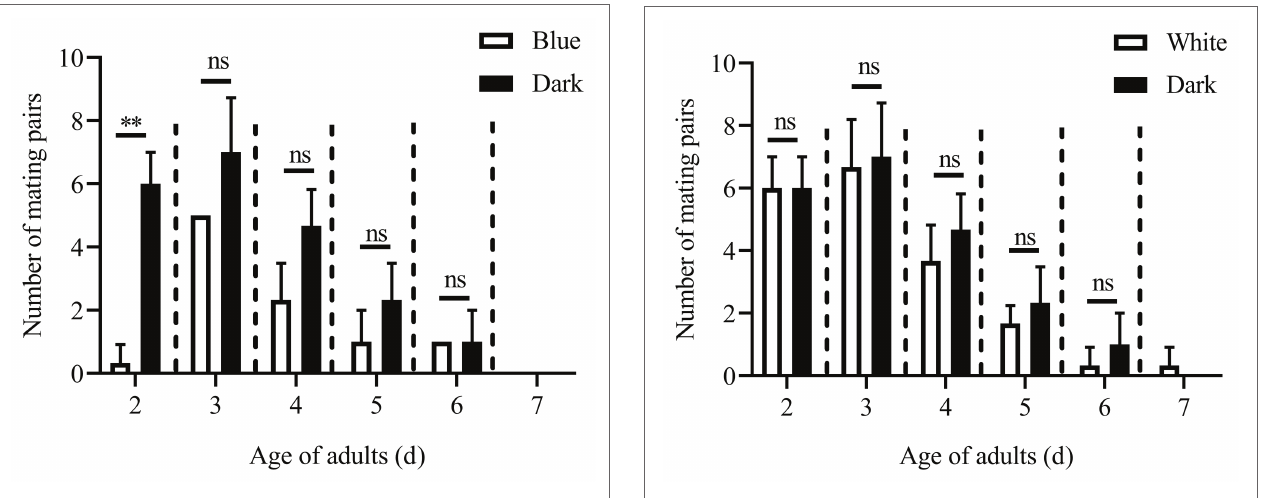
FIGURE 3 | Mating pairs of C. punctiferalis under white light and dark conditions during scotophase. Data are shown as mean ± SD, from three replicates. Asterisks above columns means significant differences ( p < 0.05, ns: no significant difference), by independent sample t